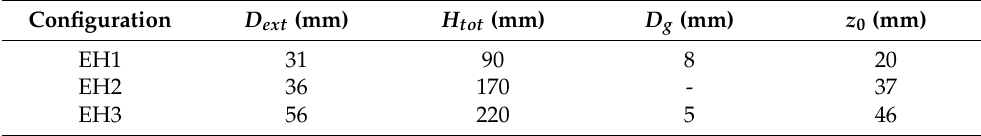
Table 1. Main dimensions of the energy